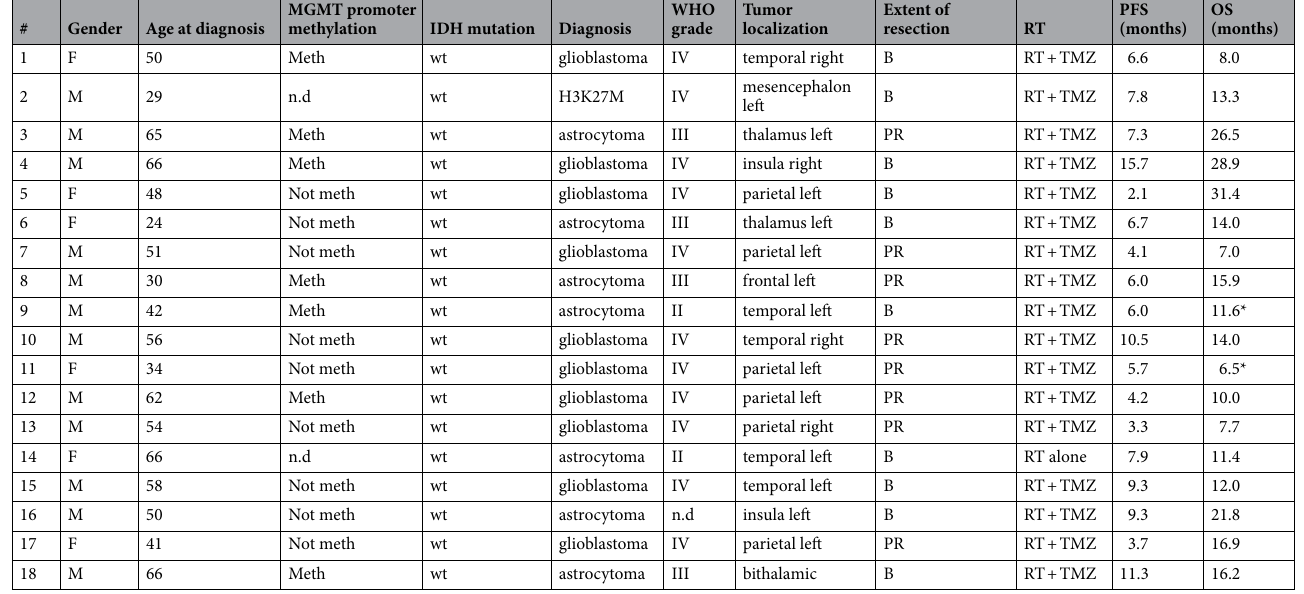
Table 1. Patient characteristics. B biopsy, F female, H3K27 H3K27-mutant diffuse midline glioma, IDH isocitrate dehydrogenase, M male, meth/not meth MGMT promoter methylated / not methylated, MGMT O 6 -methylguanine DNA methyltransferase, n.d. not determined, OS overall survival, PFS